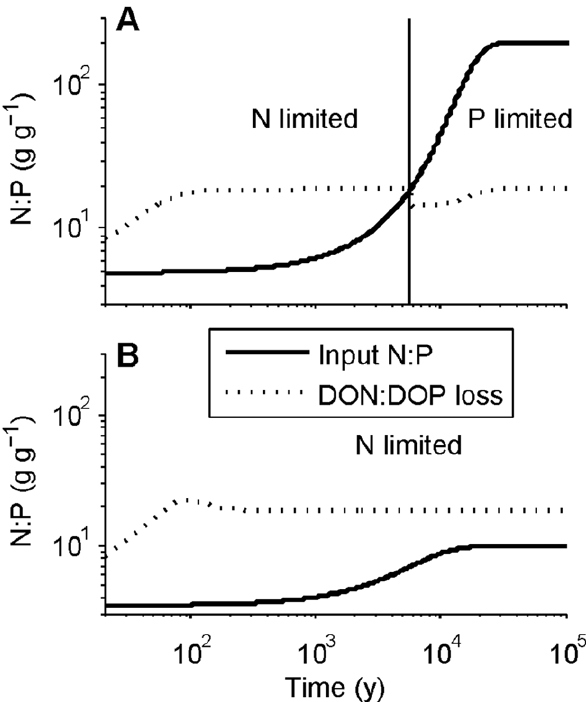
Figure 7. Contrasting effects of inputs versus losses in determining N versus P limitation over long timescales. Effects are shown for simulations in (A) Fig. 2 and (B) Fig. 4. The N:P ratio of plant-unavailable losses (termed DON:DOP in the legend for brevity, but in reality incorporating dissolved and particulate hydrologic losses and erosion losses; dotted lines) increases over decades due to preferential P mineralization (see Fig. 6), increasing the likelihood of N limitation over the intermediate and the beginning of the long timescales. On millennial and longer timescales the input N:P ratio increases due to the decline in P weathering, increasing the likelihood of P limitation over very long timescales. The transition time from N to P limitation in Fig. 2 corresponds to the crossing of the input and loss N:P ratio lines in (A) (indicated by the vertical line), which is controlled primarily by the weathering rate (see Fig. 8). In Fig. 4 and (B) there is no transition to P limitation over long timescales because the input N:P remains lower than the DON:DOP loss ratio, despite increases in both. The condition for whether limitation switches from one nutrient to the other is given in conditions 14, 15 and 18 (also see Fig. 5). The dip in the DON:DOP loss ratio when the input and loss line cross (when limitation switches) in (A) is an artifact of the timescale separation approximation–it remains constant at its saturation level in the full numerical integration (results not shown)–but all other trends reflect the true dynamics of the system. Note that both axes are logarithmic.